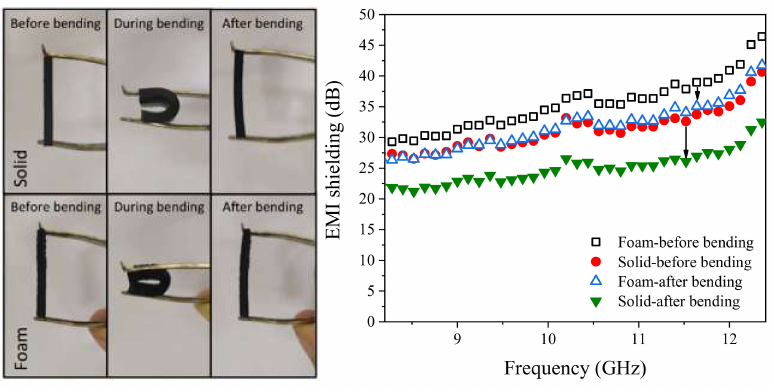
Figure 7. Photos ( left ) and EMI SE ( right ) of the samples filled with 10 phr MWCNT before and after repeated